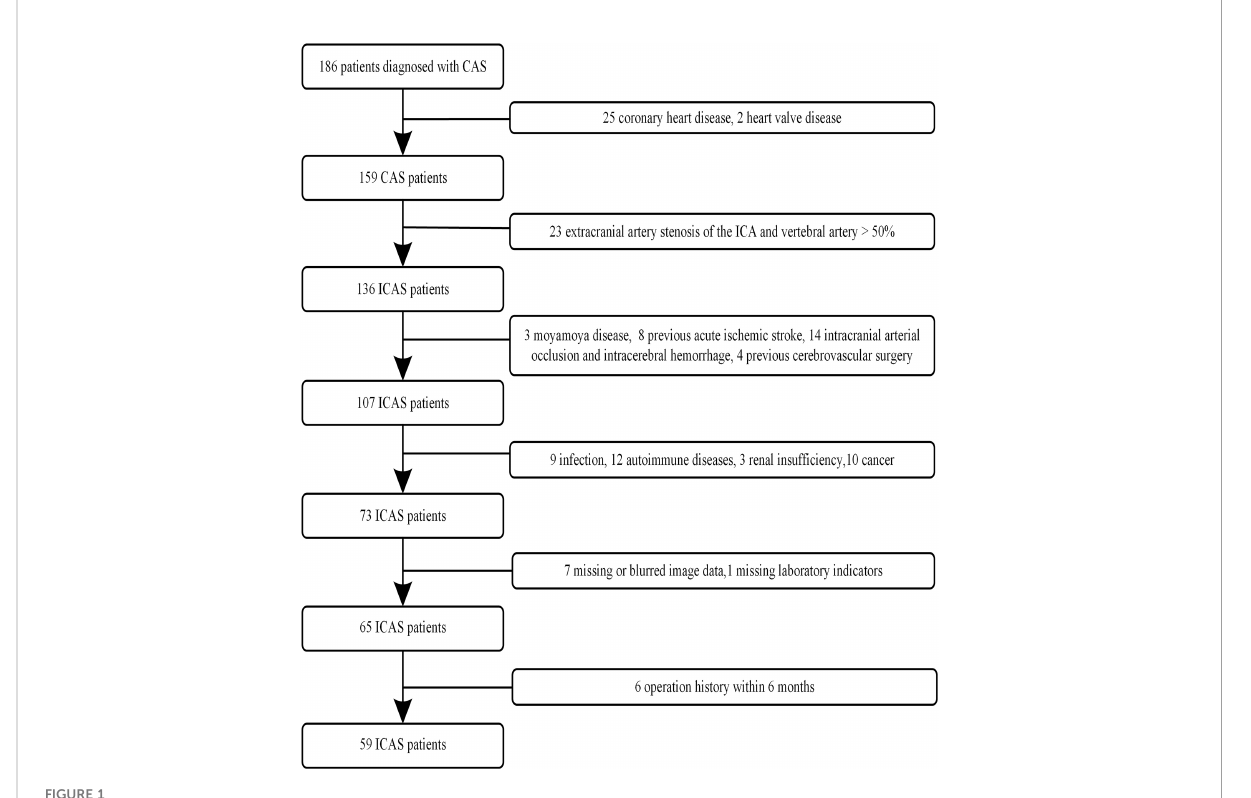
FIGURE 1 Flow diagram of the selected